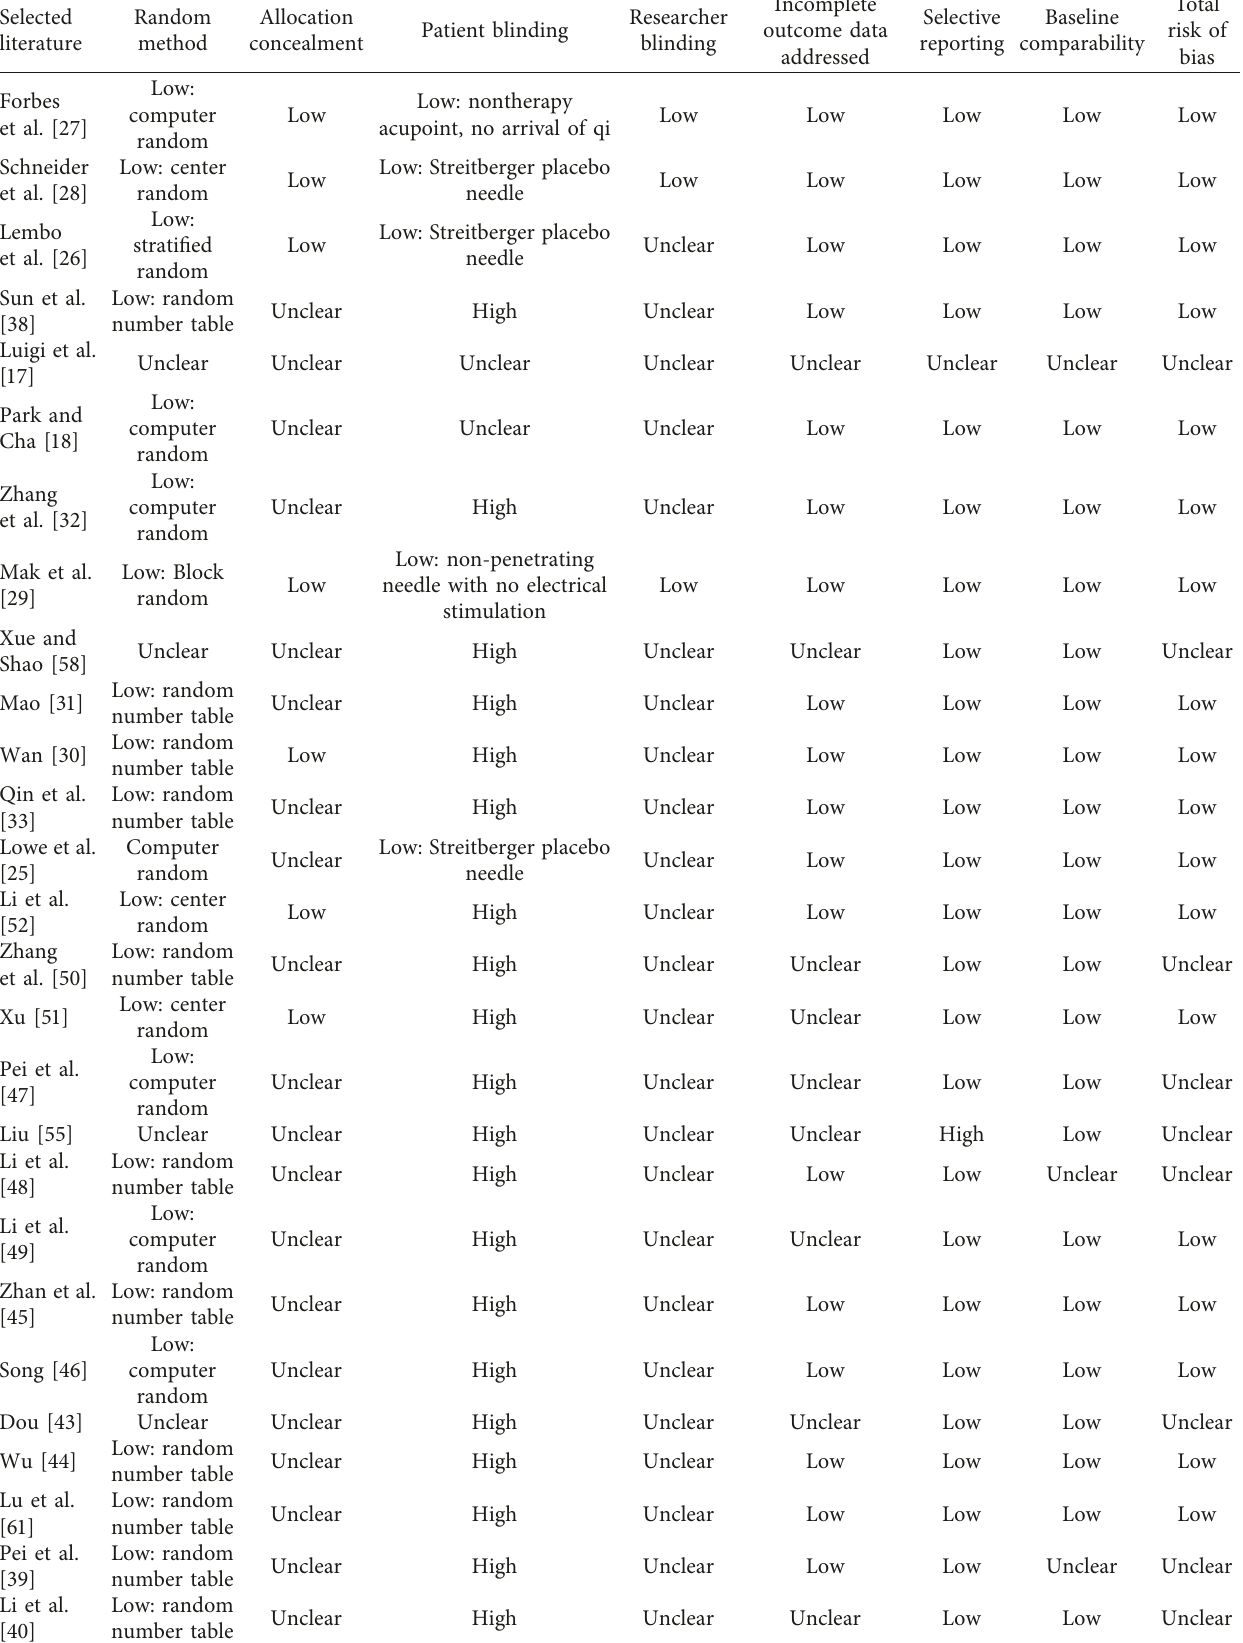
Table 1: Risk of bias